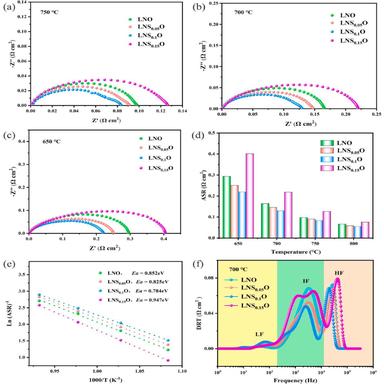
EIS of La2Ni1-xScxO4+δ (x = 0, 0.05, 0.10 and 0.15) powder at (a) 750 ◦C, (b) 700 ◦C and (c) 650 ◦C, (d) Rp in the temperature range 650–800 ◦C, (e) activation energies of La2Ni1-xScxO4+δ (x = 0, 0.05, 0.10 and 0.15), (f) the corresponding DRT curve of 700 ◦C.